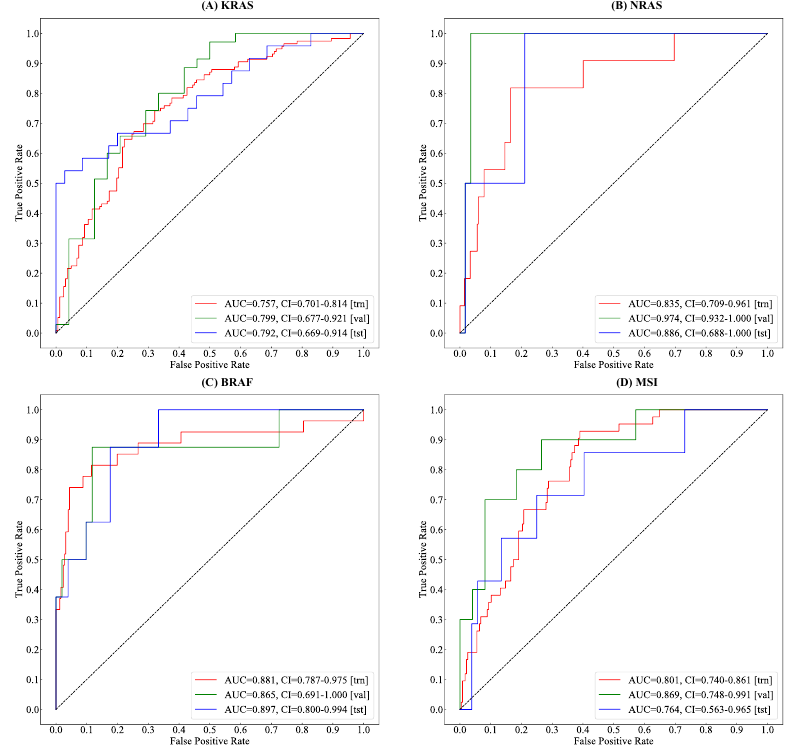
Figure 7. The receiver operator characteristic (ROC) curve and area under the curve(AUC) of Gene&MSI classification using 5&10 × tiles of the whole slide images (WSIs). ( A ) The curves of KRAS gene mutation classification. ( B ) The curves of NRAS gene mutation classification. ( C ) The curves of BRAF gene mutation classification. ( D ) The curves of MSI status